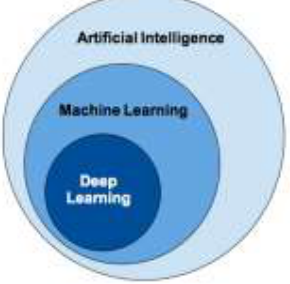
Figure 2. Artificial intelligence, machine learning and deep learning (Wasicek,